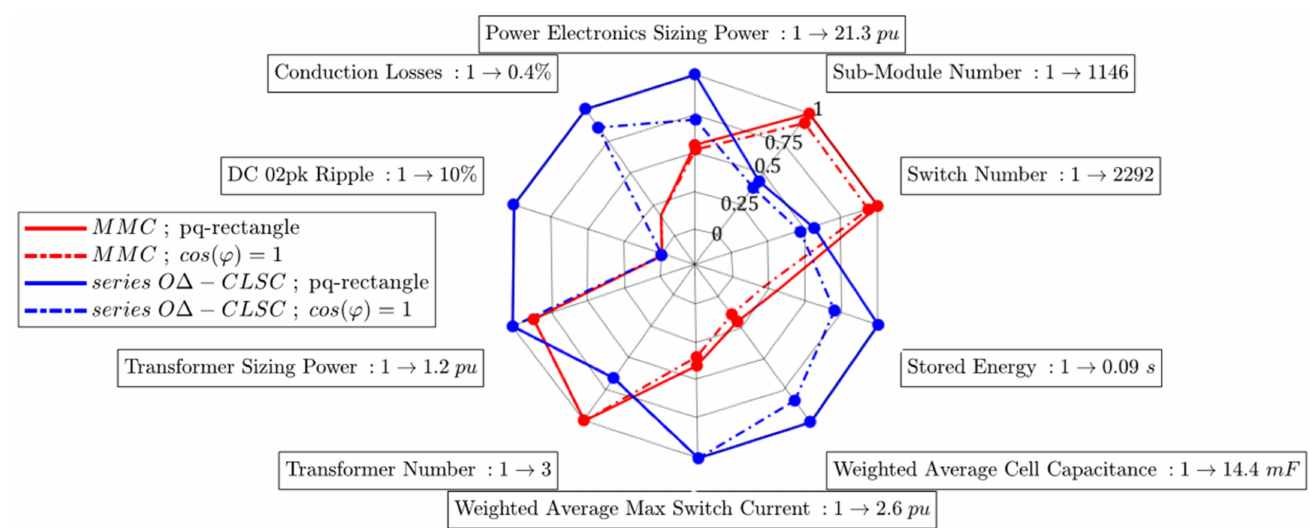
Figure 19. KPI spider plot. The notation “1 → x ” means that 1 in the spider plot corresponds to the value x